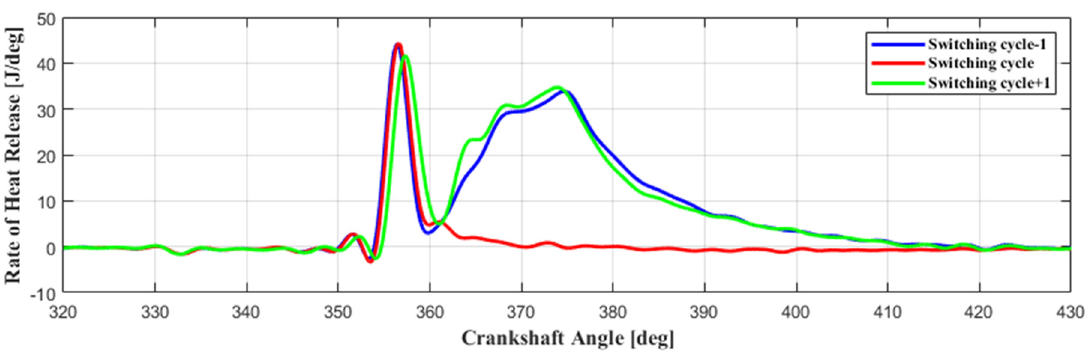
Figure 10. Effect of different residual gases temperature: RoHR for cycles before (blue) and after (green) the switching cycle (red).